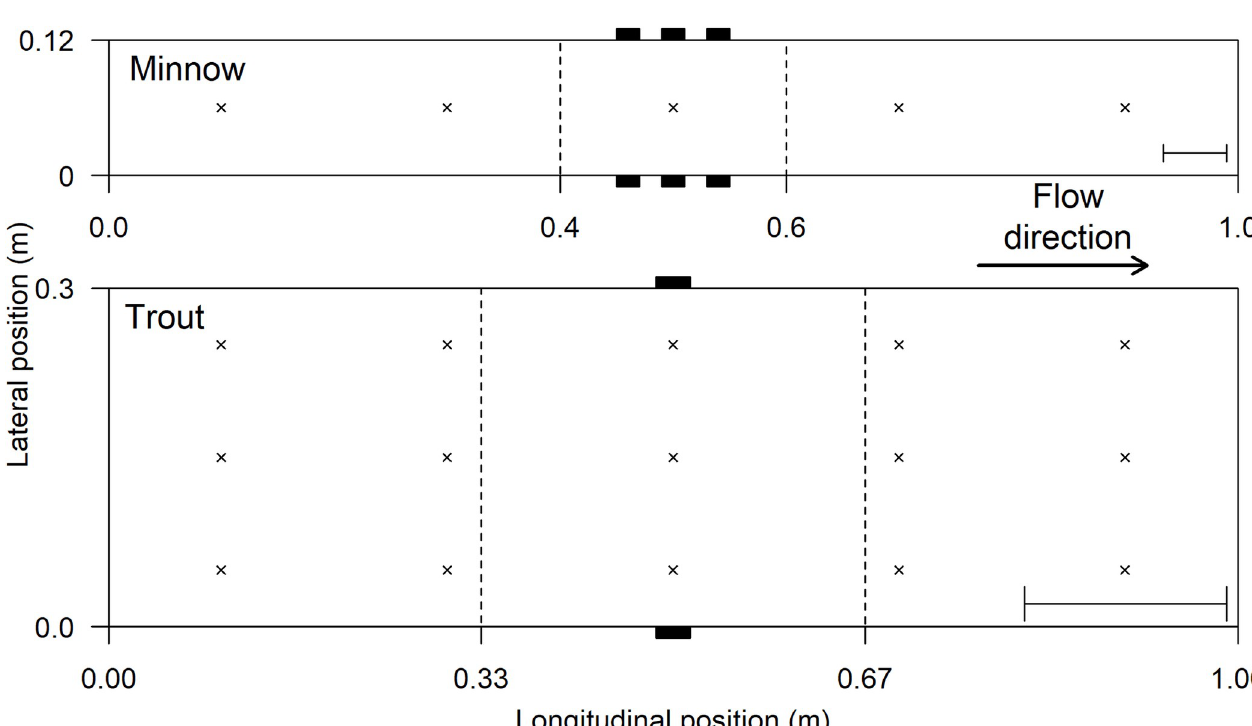
Fig 1. Plan view of the experimental set-up for minnow (top) and trout (bottom). The experimental area was isolated from the rest of the flume using tubular flow straighteners (upstream and downstream). Dotted lines display the central zone and small black boxes at the sides of the flume the position of the visual cues (vertical stripes). The positions of flow measurements are indicated by small crosses. Flow was from left to right. The scale bar in the bottom left of each box represents the mean fish fork length for that species.